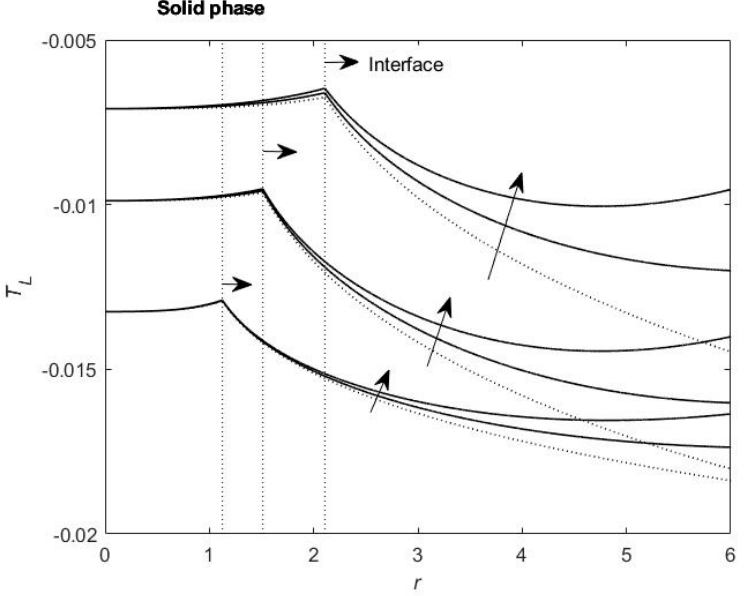
Figure 7. The variations in the temperature near the interface along the growth direction θ = 7 π /12 under the different shear rates A 0 = B 0 = 0,3.0,6.0 (from bottom to top) at different times t = 1.0,2.0,3.0, where α 4 = 0.25, r 0 = 1.1 R ∗ , Γ = 0.4545, and ∆ T = 10. By contrast, the dashed line denotes the columnar crystal growth velocity without the shear flow. Arrows indicate trends as the crystal growth temperature